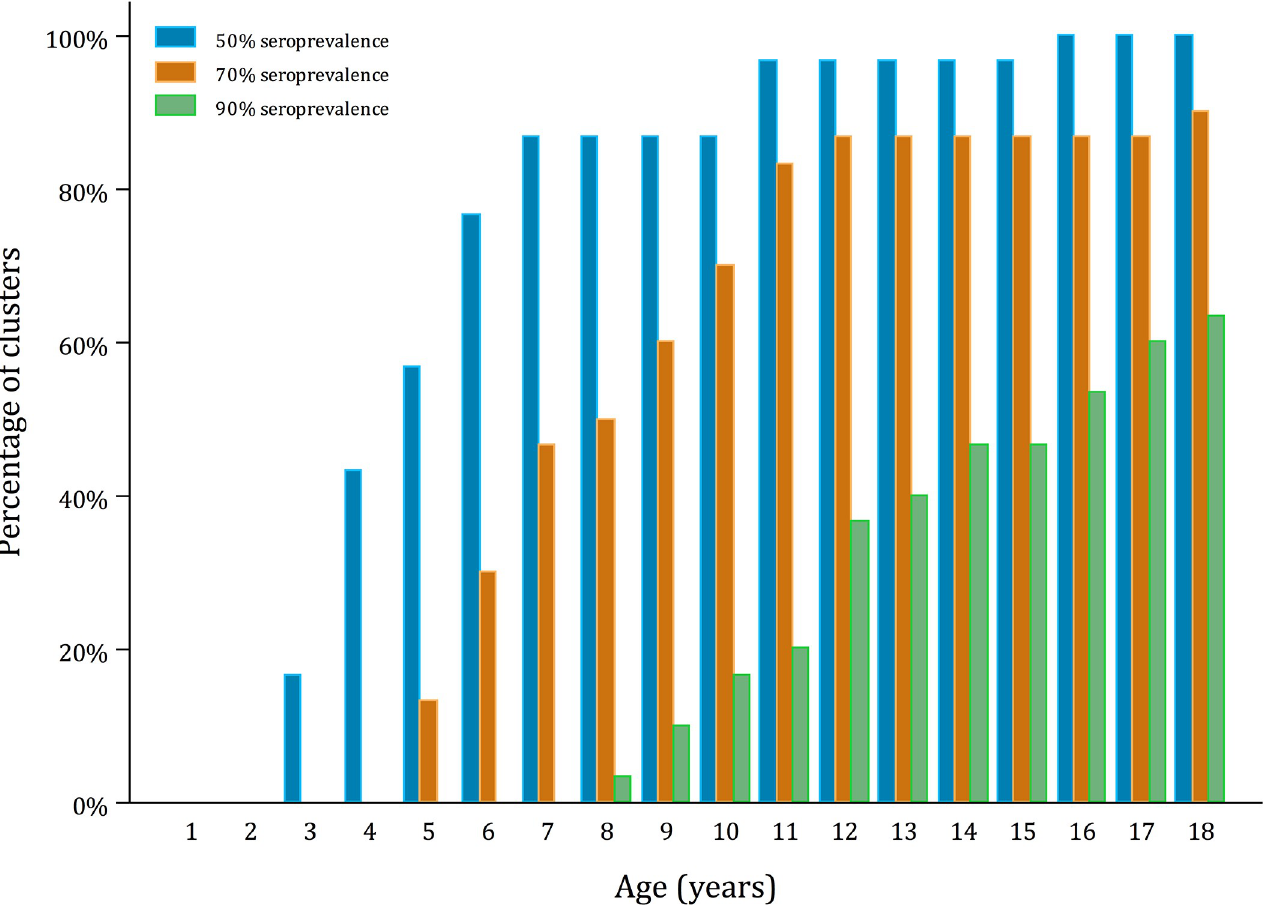
Fig 4. Proportion of clusters expected to reach seroprevalence levels of 50%, 70% and 90% by year of age, based on models with an age-constant force of